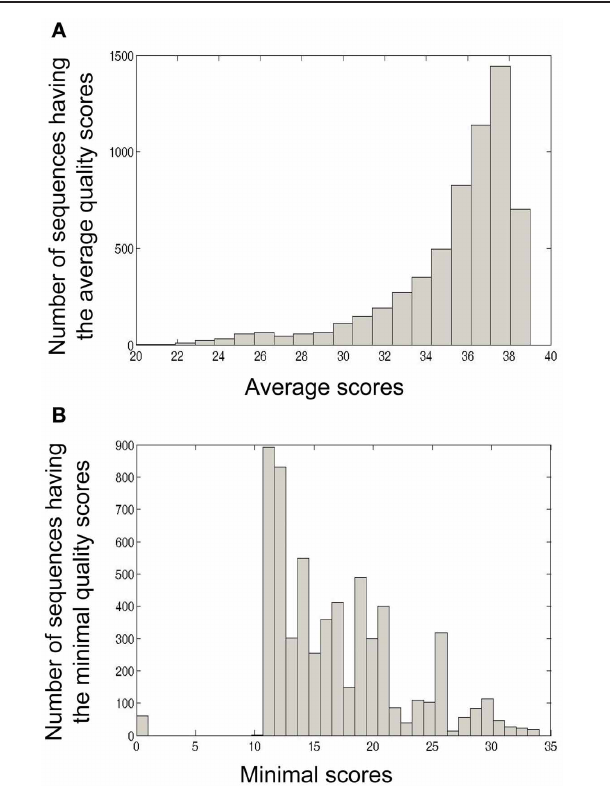
FIGURE 5 | Four formalin-fixed paraffin-embedded (FFPE) reactive lymph node tissues, archived about 10 years ago, from adult patients, were used as part of a study that dealt with Ig repertoire analysis of gastric lymphomas. In the current paper we used these samples in order to demonstrate quality scores obtained by the 454 platform using FFPE tissues. (A) Average quality score distribution of sequences obtained from four LN samples. For each sequence, the average quality score was calculated as the sum of all base scores divided by the length of the sequence. (B) Minimal quality score distribution of sequences obtained from four LN samples. For each sequence, the minimal quality score was calculated as the minimal base score value of all base scores in the